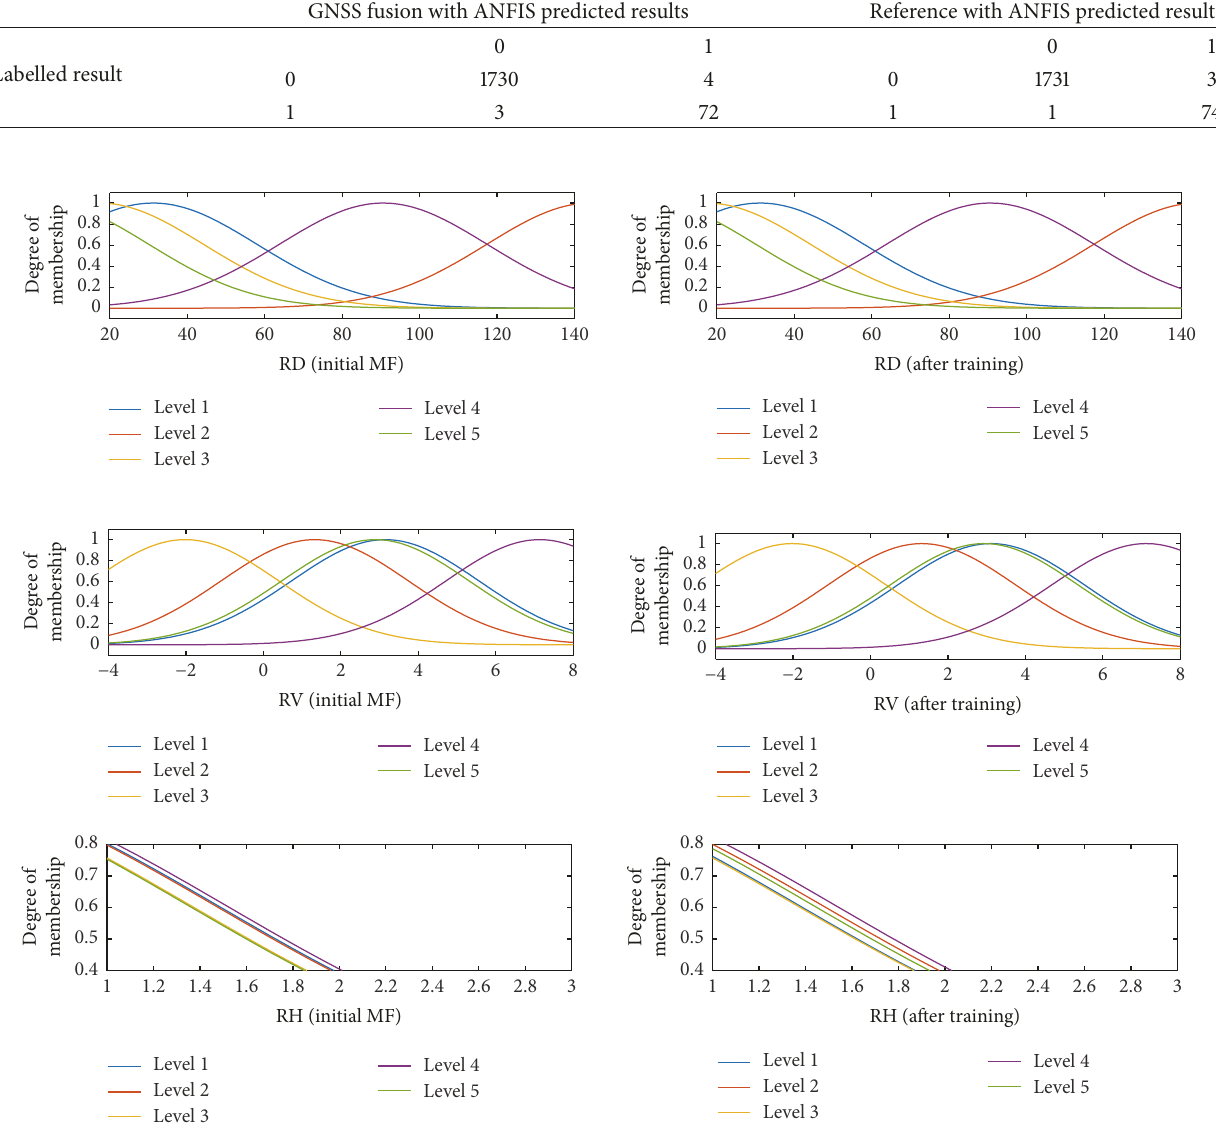
Figure 7: Membership function before and after training with ANFIS.